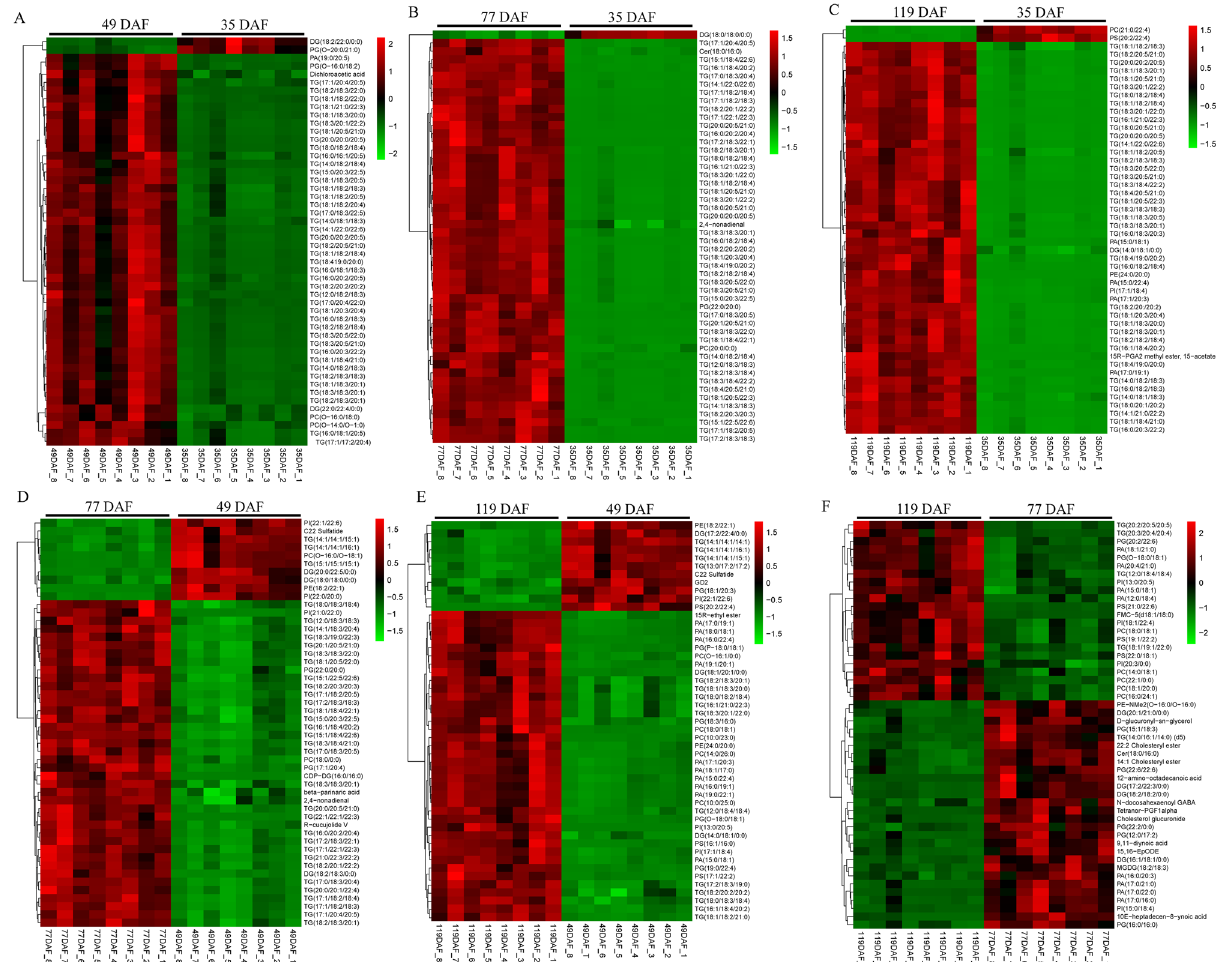
Figure 2. Hierarchal-clustering heatmaps showing differences in lipid abundance (based on VIP value) between developmental stages in the Paeonia ostii